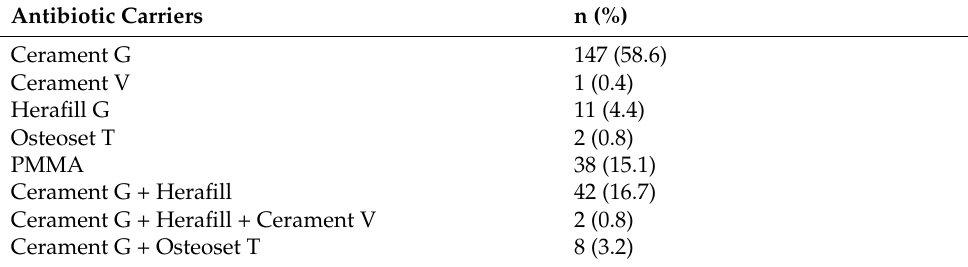
Table 4. Overview of the antibiotic